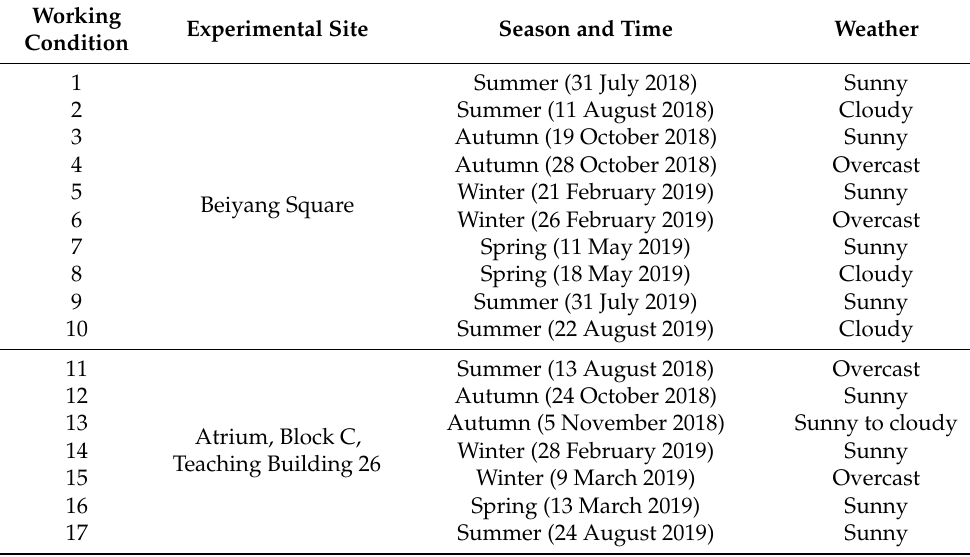
Table 1. Basic working condition information of radiation comparison measured experiment.